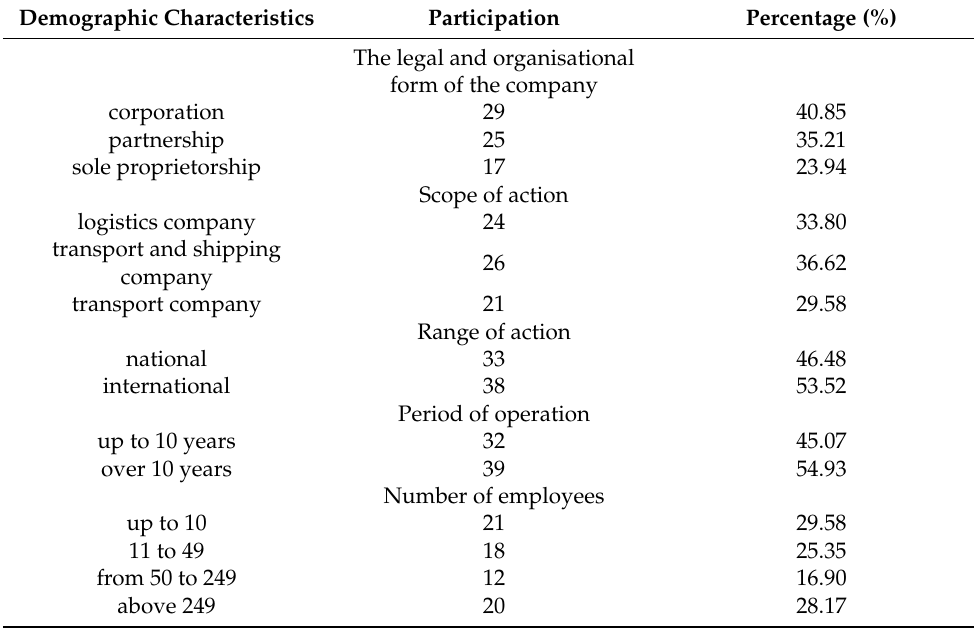
Table 2. Characteristics of